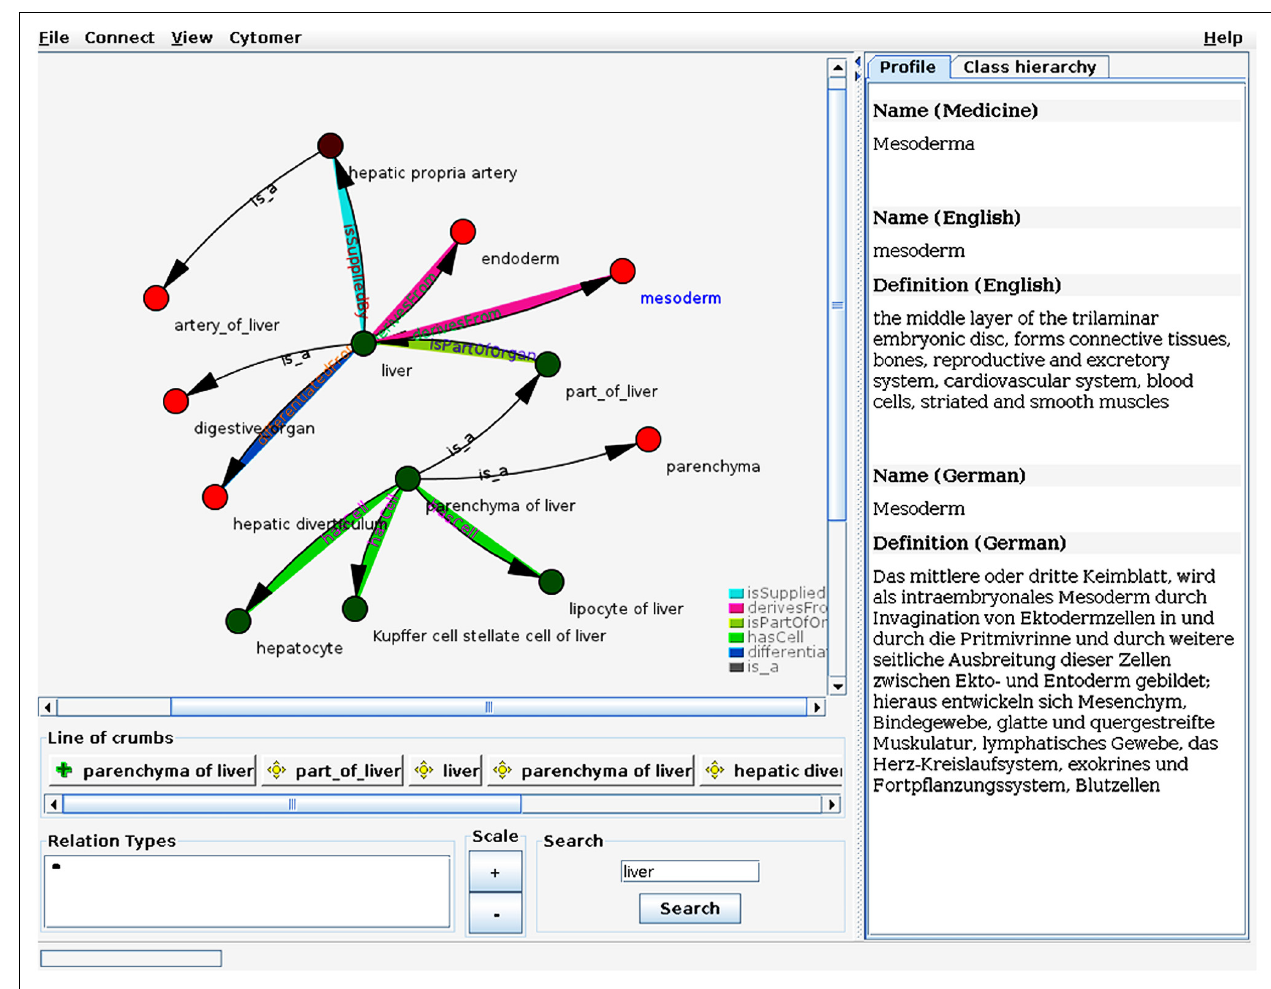
color of the nodes indicates the physiological system the class belongs to and is retrieved from the OBA service. On the tabs of the right side additional information of the selected ontology class is displayed, or the class hierarchy of the classes in the graph (tab is hidden in the